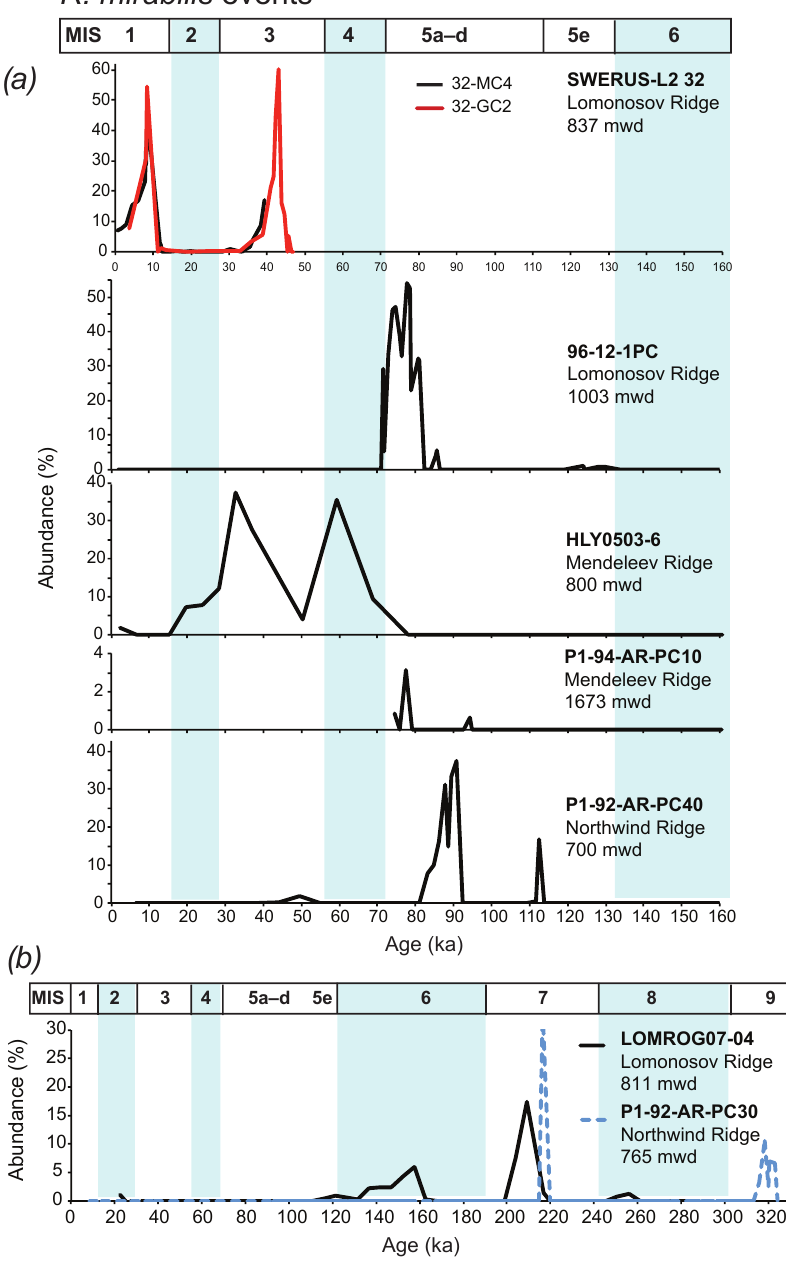
Figure 7. (a) Relative frequency (percent abundance) of R. mirabilis in SWERUS-32 cores and in central Arctic Ocean cores, 160ka to present. (b) R. mirabilis in core LOMROG07-04 from 260ka to present and in core P1-92-AR-PC30 from 340ka to